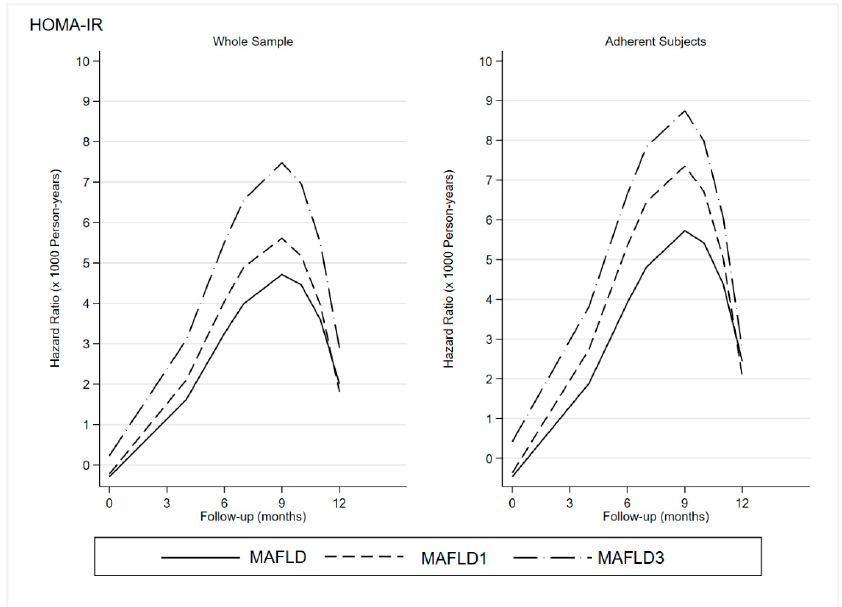
Figure 2. HOMA-IR: Effect of Adherence to LGIMD and CEP on Hazard Ratio of Time-to-Event (Loss of MAFLD Diagnostic Criteria for the Whole Sample and Adherent Participants). HOMA-IR: Homeostatic Model Assessment for Insulin Resistance; MAFLD: Metabolic-Associated Fatty Liver Disease: MAFLD1; presence of hepatic steatosis in overweight/obese subjects; MAFLD3: presence of hepatic steatosis and type 2 diabetes mellitus.